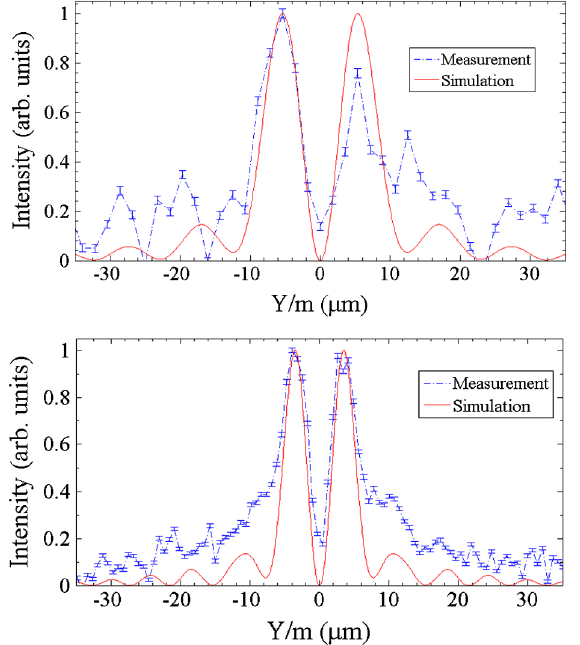
FIG. 13. Vertical projection of the PSF measured and simulated with the plano-convex lens (top) and the achromatic lens (bottom) at the best focus ( γ ¼ 2500 ; λ ¼ 550 nm).